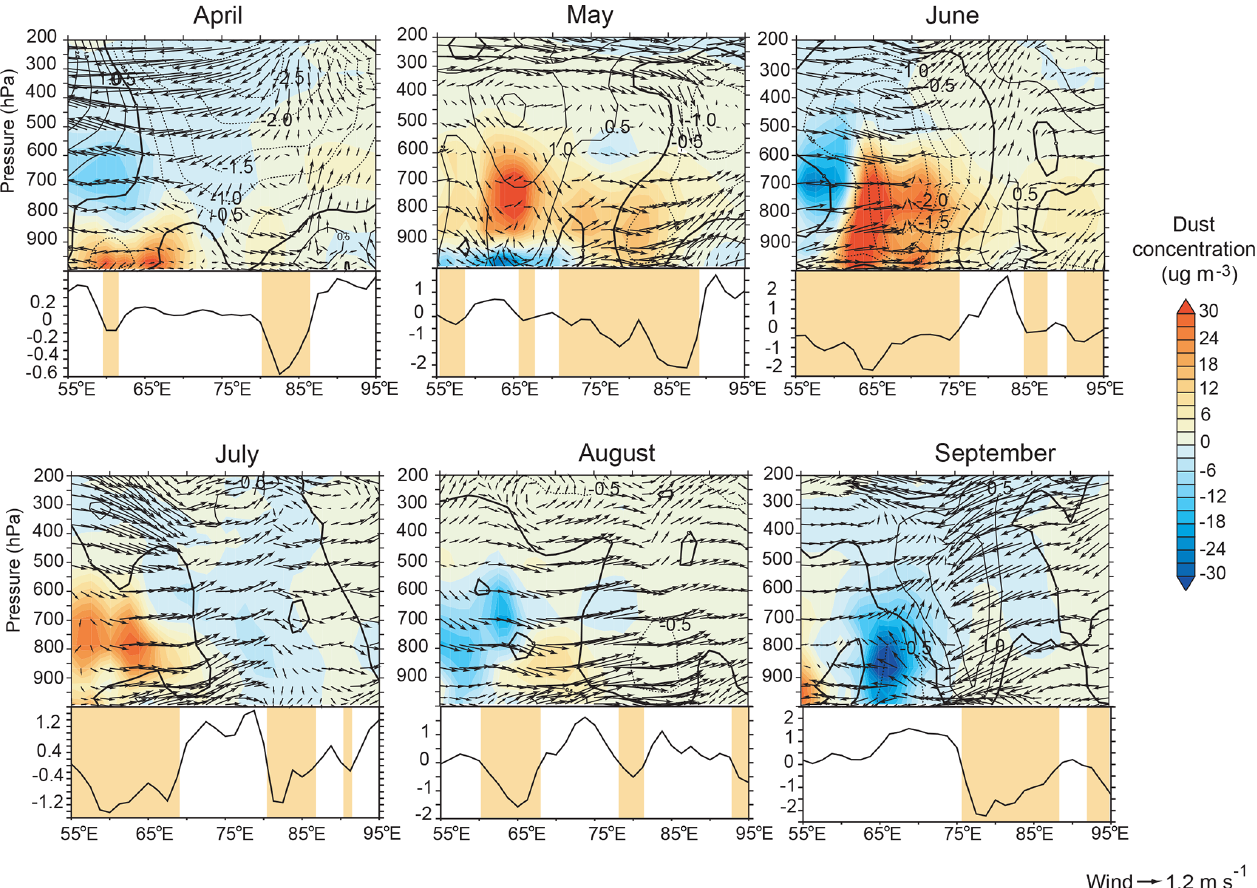
Figure 11. Sections along 25 ◦ N illustrating month-wise differences in dust transport between the CESM NAtl and CESM Ctrl simulations. In the upper part of each panel, shading indicates the difference in dust concentrations between the two simulations, the vectors are the differences in the zonal and vertical components of wind, and the contours are the differences in the meridional component of wind. Solid (dashed) contours indicate southerly (northerly) wind anomalies. The lower part of each panel plots precipitation differences (in mmd − 1 ) between the CESM NAtl and CESM Ctrl simulations along 25 ◦ N. The orange shades indicate the longitudinal belts that have negative precipitation anomalies. Note that the vertical velocity is expressed as pascals per second (Pas − 1 ) and has been multiplied by